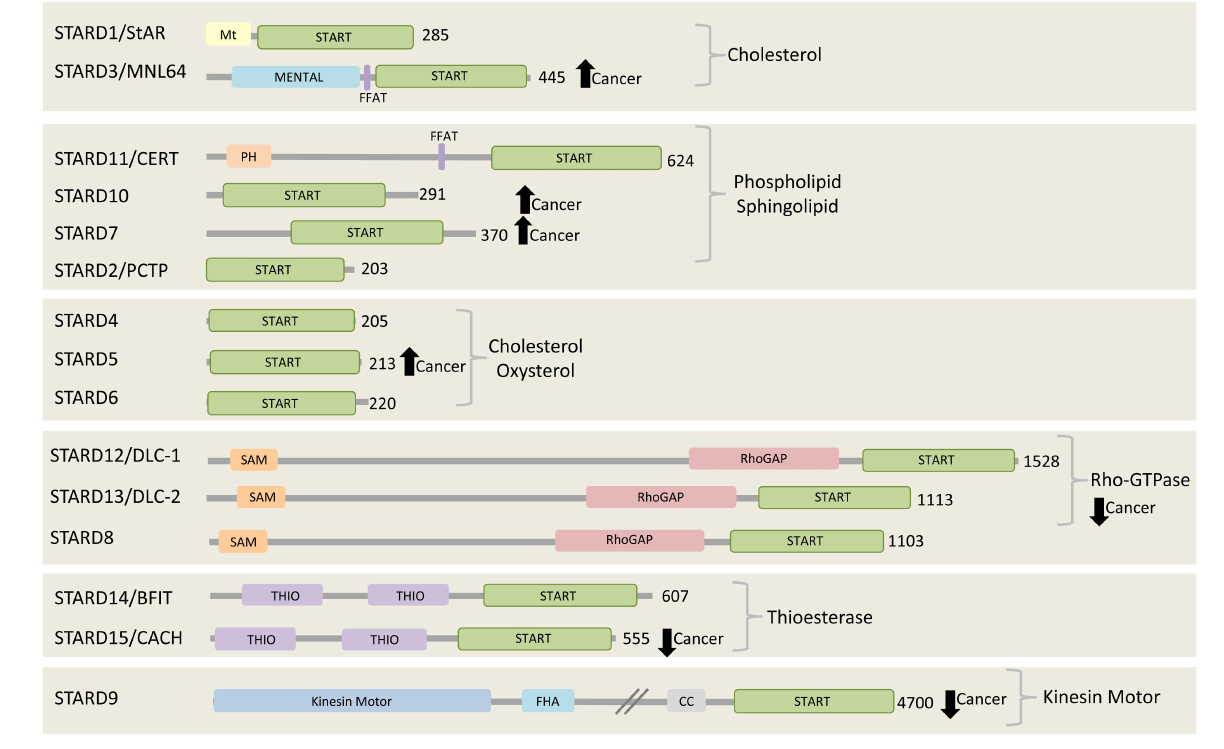
FIGURE 2 | The START proteins. Fifteen START proteins in human are grouped into six subfamilies. Three groups share the indicated lipid binding/transfer specificity of START domain, while the other three groups share the indicated functional domains. All members have their START domain at the C-terminal region. Among 15 START proteins, two of them, STARD3 and CERT, contain FFAT motif. STARD3, STARD10, STARD7, and STARD5 are found to be highly expressed and connected to poor prognosis in various cancers including breast cancer, gestational trophoblastic tumor (Clark, 2012). On the other hand, the expression of all members of Rho-GTPase subgroup, STARD8/12/13, STARD9, and STARD15 are reported to be decreased in cancer (Clark, 2012). The number at the right side of each C-terminal represents the length of each protein in amino